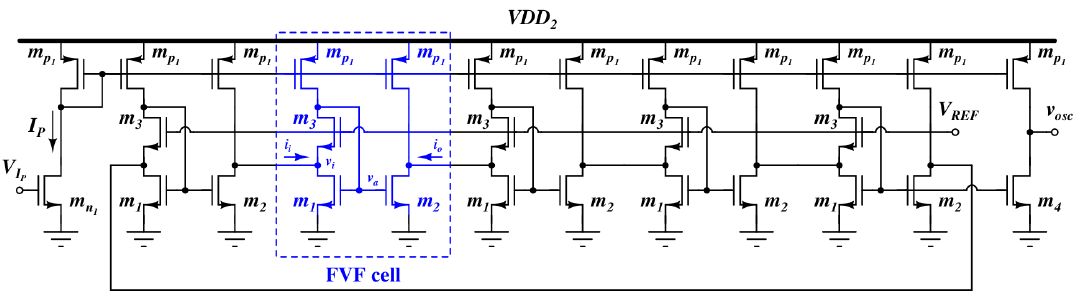
Figure 2. Block diagram of the proposed ring